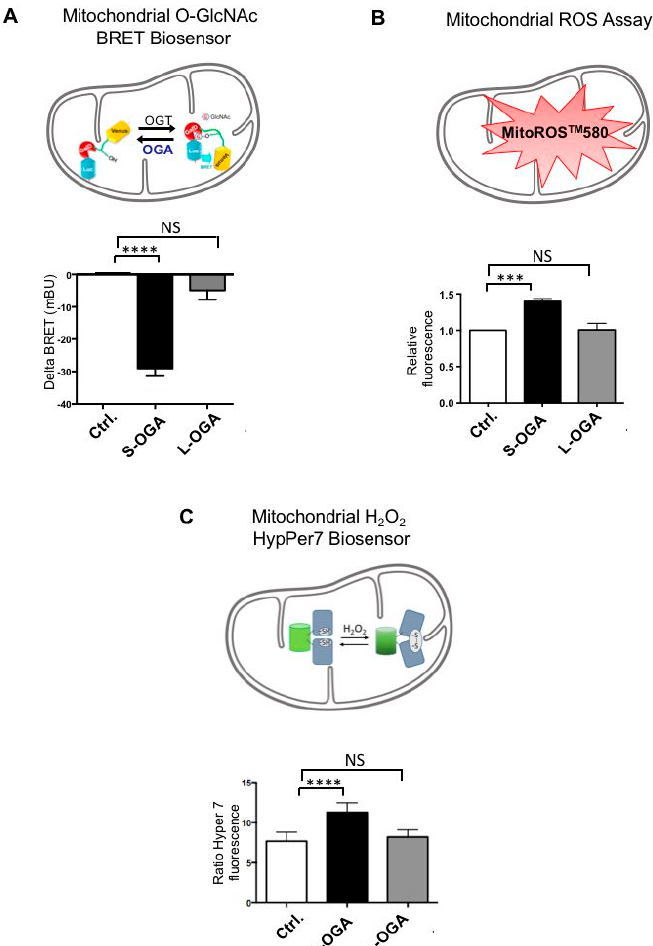
Figure 4. Short OGA expression reduced O-GlcNAcylation and increased ROS levels in the mitochondria. ( A ) HEK-293T cells were co-transfected with the mitochondria-targeted BRET biosensor and either pcDNA3, S-OGA, or L-OGA. The graph shows the difference in BRET signal (delta BRET, expressed in milliBRET units) between pcDNA3 transfected cells and either S-OGA or L-OGA transfected cells ( n = 9; ****: p < 0.0001, NS: non-significative). S-OGA markedly reduced BRET signal, indicating decreased O-GlcNAcylation of the mitochondrial O-GlcNAc biosensor by this isoform. ( B ) HEK-293T cells transfected with pcDNA3, S-OGA, or L-OGA were incubated for 1 h with MitoROS TM 580. Fluorescence emission at 590 nm was then measured after excitation at 540 nm. Results are expressed as fluorescence in S-OGA or L-OGA transfected cells relative to pcDNA3 transfected cells ( n = 5; ***: p < 0.001; NS: non-significative). ( C ) HEK-293T cells were co-transfected with the mitochondria H 2 O 2 biosensor (HyPer7) and either pcDNA3, S-OGA, or L-OGA. In each experiment, the ratio of fluorescence emission at 516 nm after excitation at 499 nm to fluorescence emission at 516 nm after excitation at 400 nm was determined. Results are expressed as 499/400 ratio in pcDNA3, S-OGA, or L-OGA transfected cells ( n = 13, ****: p < 0.0001, NS: non-significative).